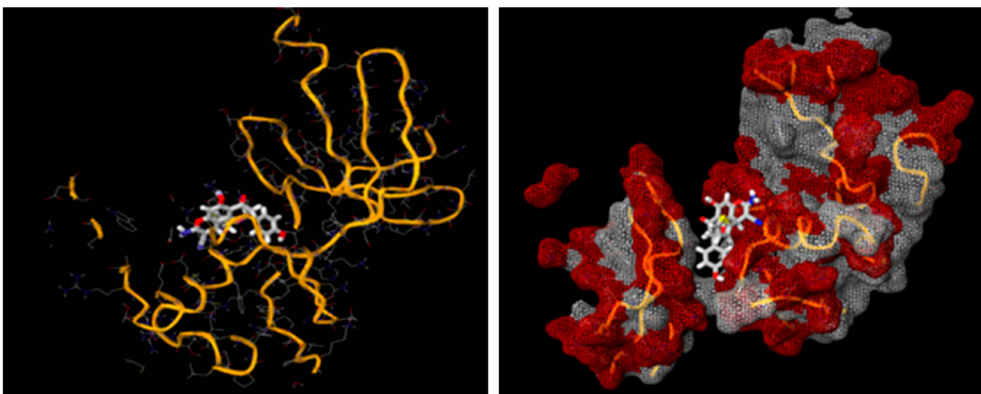
Figure 10. Docking of Compound 2e into the active site of the cyclin-dependent kinase-2 (CDK2, PDB ID: 1FVV). (The compound 2e structure in this figure is a 3D molecular structure where blue color is associated with nitrogen, grey with carbon, red with oxygen, yellow with sulfur, white with hydrogen atoms).